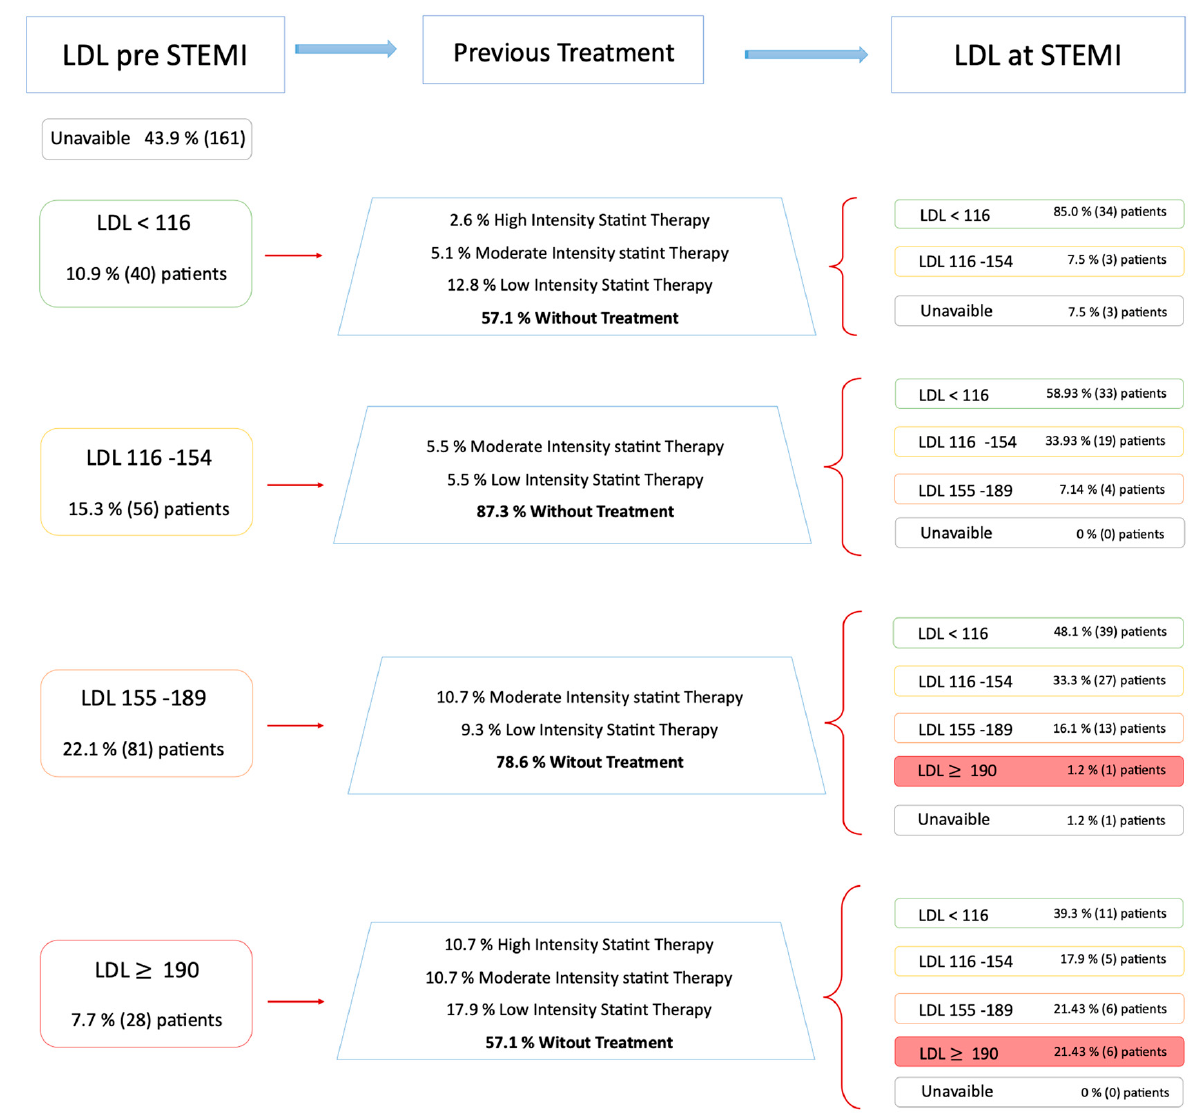
Figure 3. Evolution and management of patients of LDL levels available prior to STEMI.